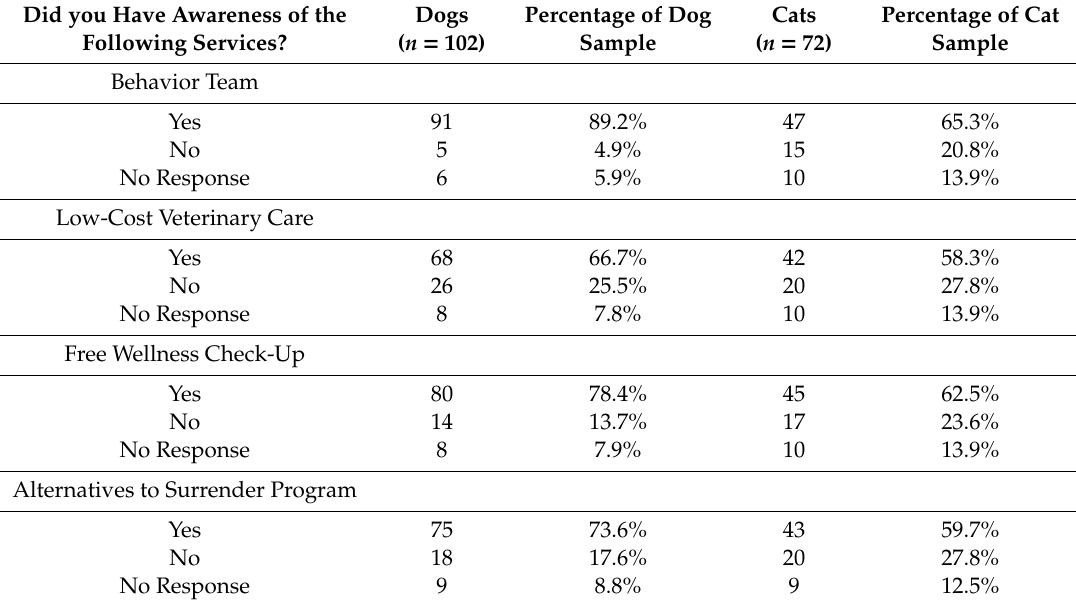
Table 7. Awareness of pet-support services provided by the shelter.